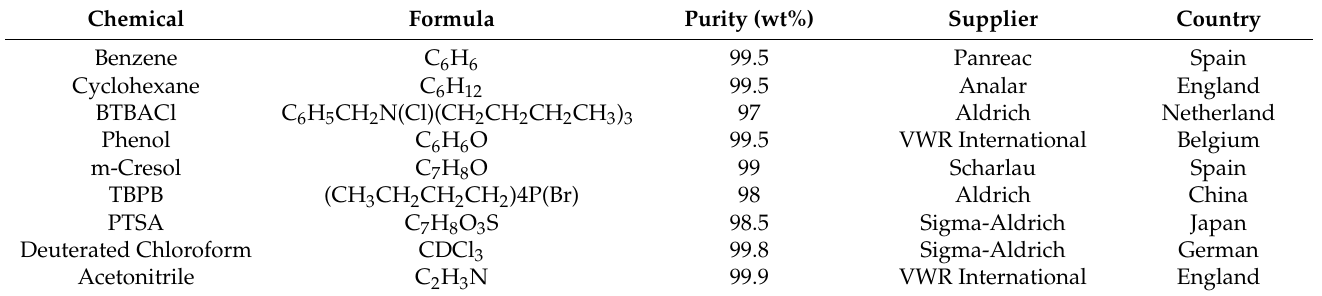
Table 4. List of chemicals used in the experimental